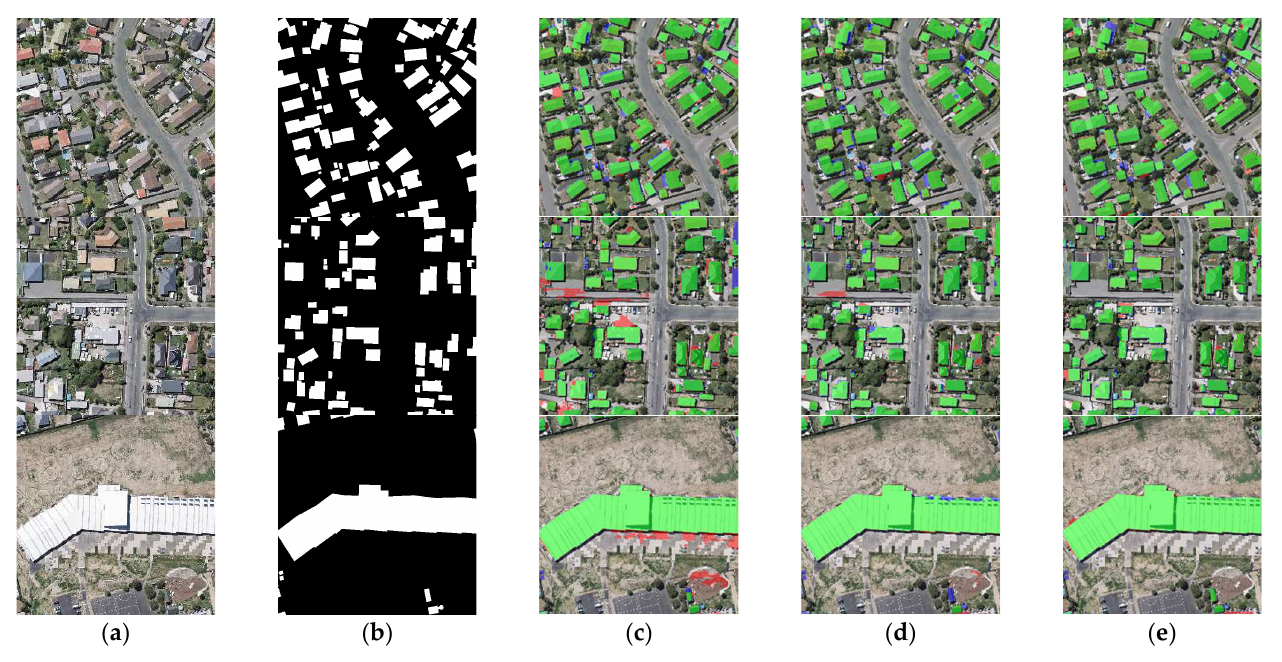
Figure 13. Comparison of ablation experimental results on the WHU dataset. ( a ) Original image. ( b ) Ground-truth. ( c ) ResNet +AAP. ( d ) ResNet +DGC. ( e ) ResNet +AAP +DGC. Note, in Columns ( b – e ), black, white, green, blue, and red indicate true, false, true-positive, false-negative, and false-positive, respectively. Table 3. Accuracy statistics of the ablation experiment on the WHU dataset. The best scores are highlighted in bold.